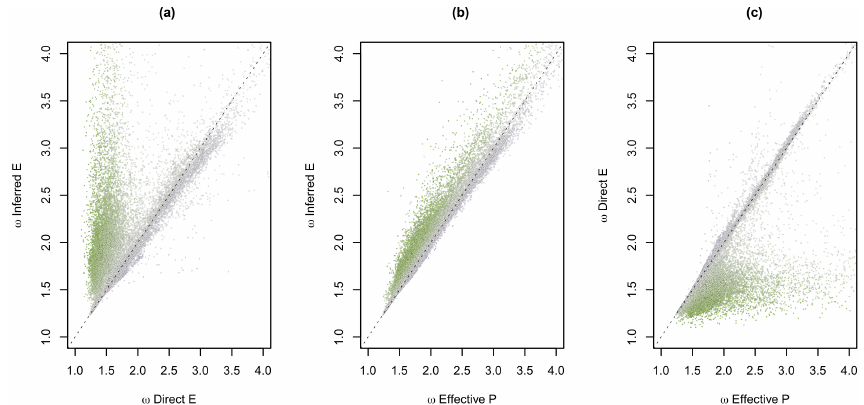
Figure 8. Comparison of shape parameters between the three approaches for every watershed. Points are colored by groundwater contribution fraction as shown in Fig. 3d. The dashed line on each plot is a one-to-one line for reference.